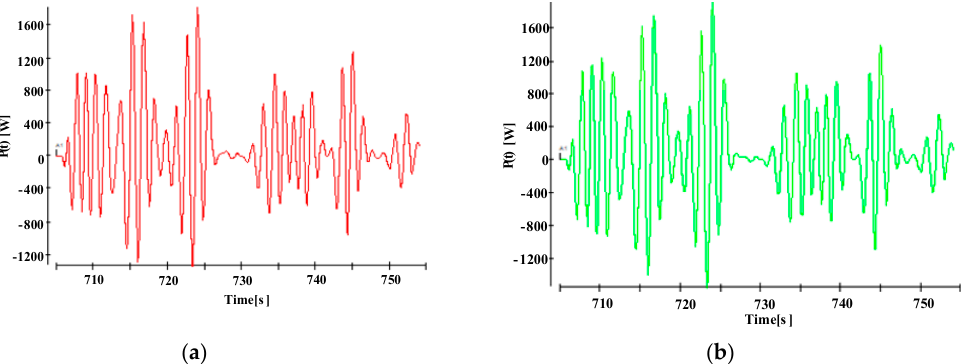
Figure 15. Measured instantaneous mechanical power of the synchronous test bench. ( a ) FPA and ( b ) hill-climbing method.